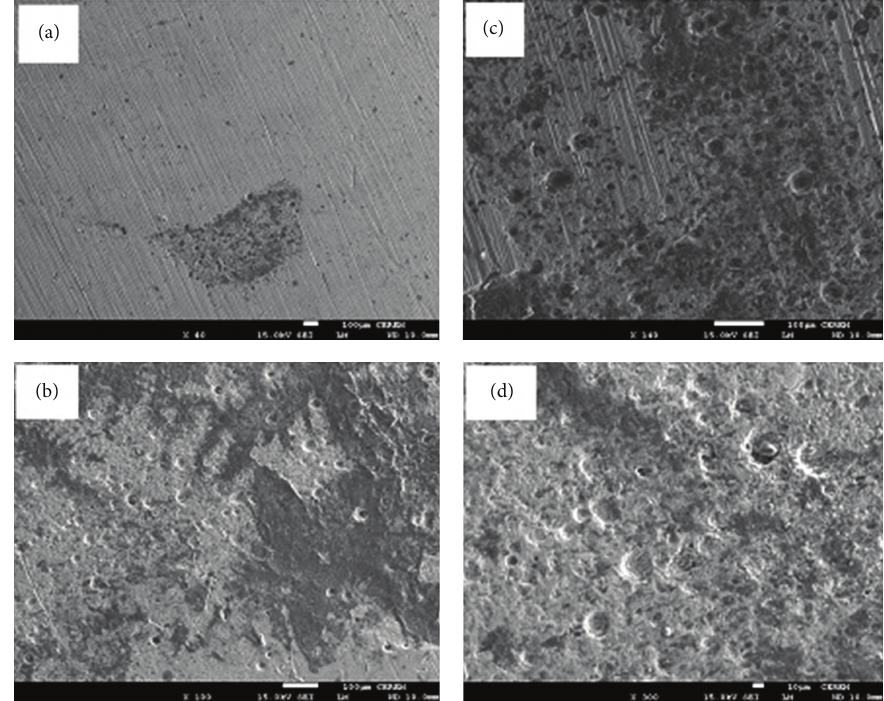
Figure 8: SEM micrographs obtained on the API X70 pipeline steel electrode after its immersion for 20 h in the Arabian Gulf seawater then stepping the potential to − 0.35 V versus Ag/AgCl for